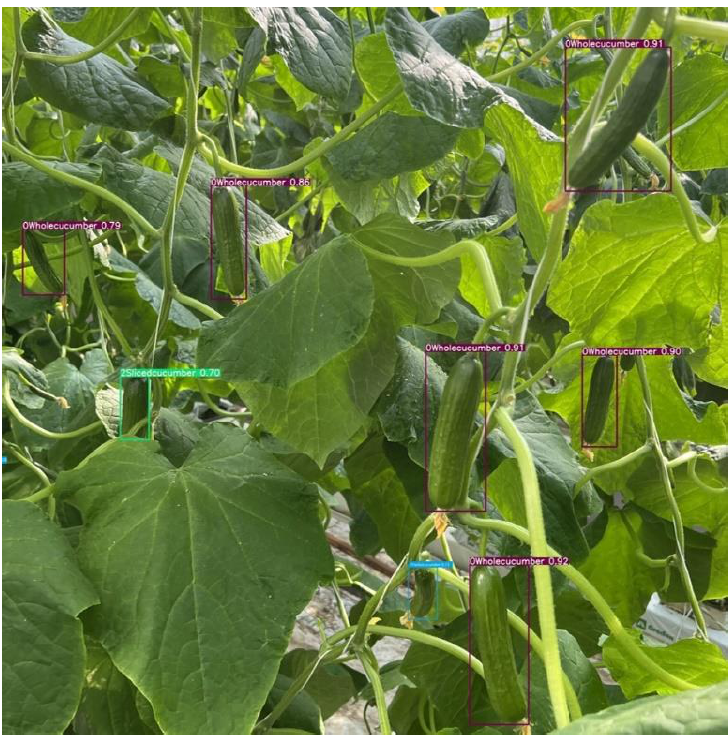
Figure 10. Detection effect of the enhanced YOLOv5s model. Table 4. Statistical table of prediction